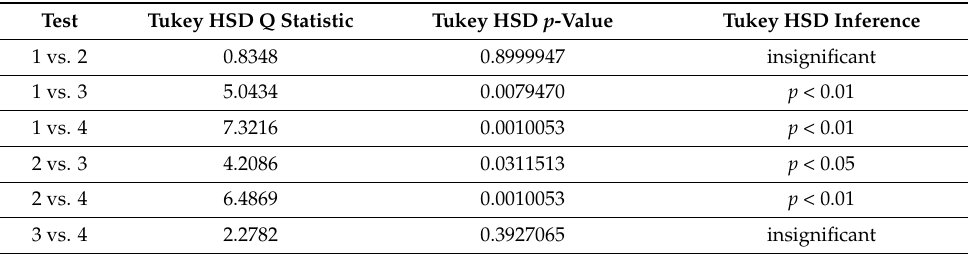
Table 11. Disorientation SSQ score Tukey HSD